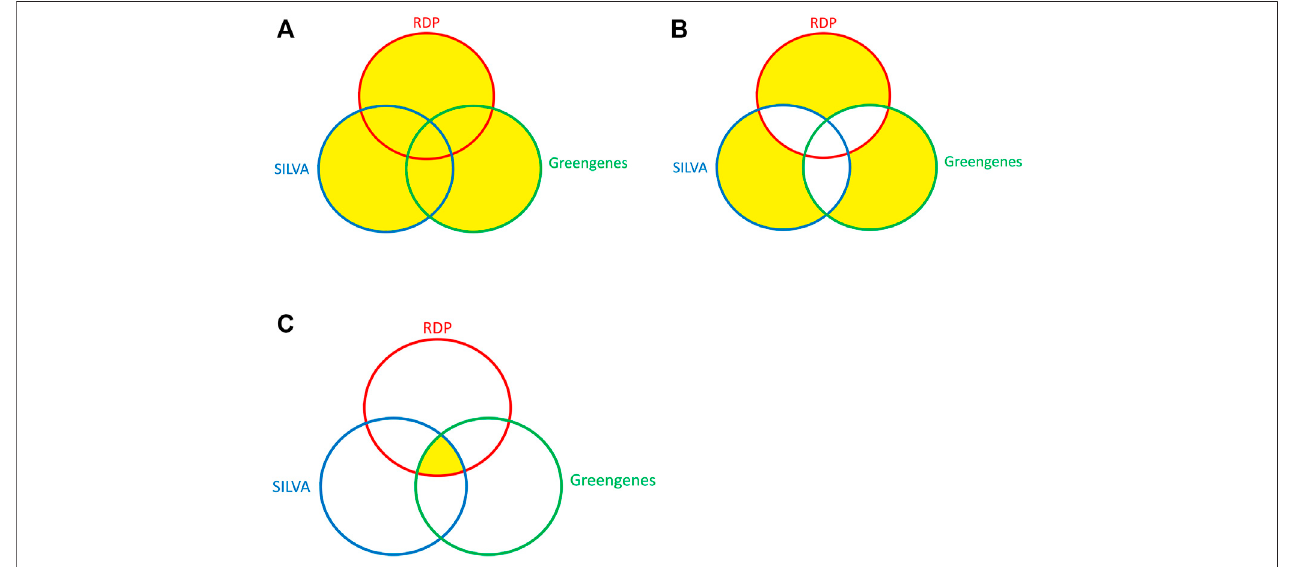
FIGURE 2 | The Venn diagram of the Union, Exclusion, and Intersection datasets. (A) Union, (B) Exclusion, and (C)